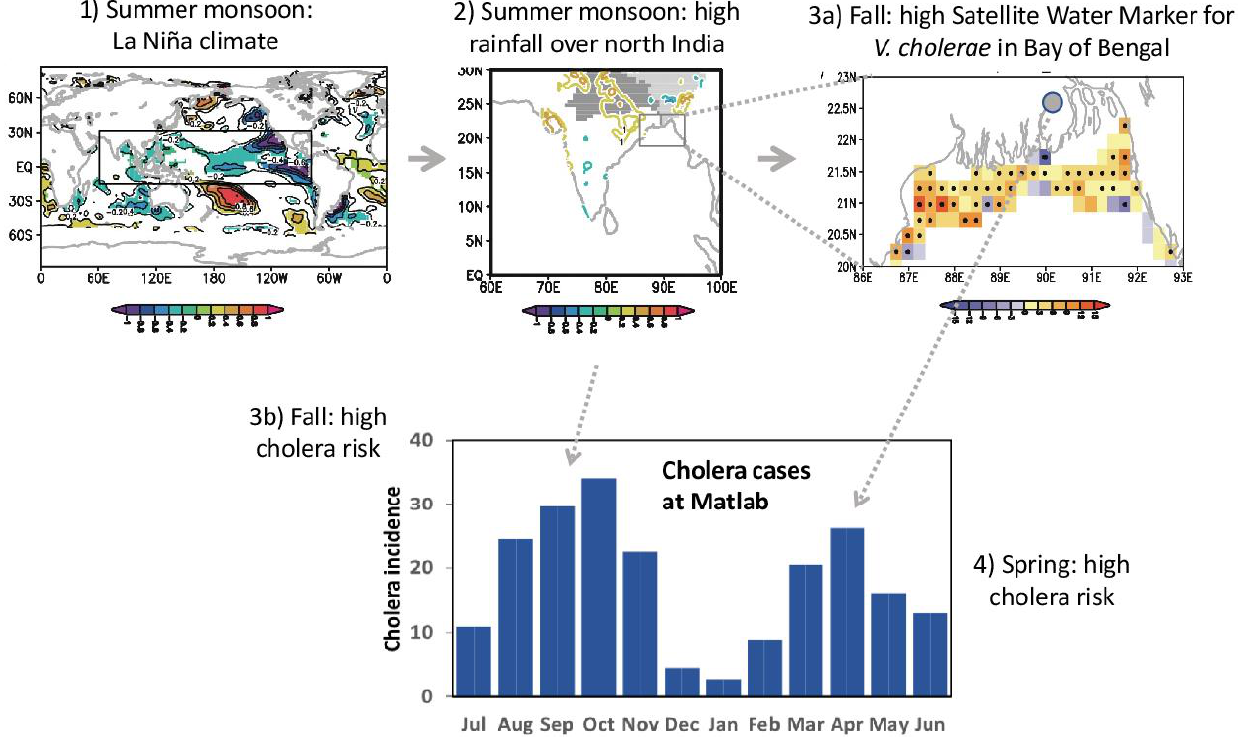
Figure 3. Mechanistic link between climate conditions and seasonal cholera in Bay of Bengal coastal region. In steps (1), (2), and (3a), composite maps are defined as high years (exceeding ±1𝜎 ) of the October–December (OND) SWM index over the north BoB (20–23° N, 85–95° E). (1) June–September SST anomaly, (2) normalized August–September rainfall anomaly (only ±1𝜎 , ±1.5𝜎 and above are contoured), (3a) SWM anomalies in OND. Only areas above 90% significance are shown. Composite maps are produced over the period 1997–2016. In steps (3b) and (4), monthly average number of cholera cases recorded at Matlab (a district of Bangladesh) over the period 1998–2007. The cholera data have been digitized from Akanda et al. (2009, their Figure 1a) using WebPlotDigitizer software (https://automeris.io/WebPlotDigitizer/, accessed on 02 March 2021).